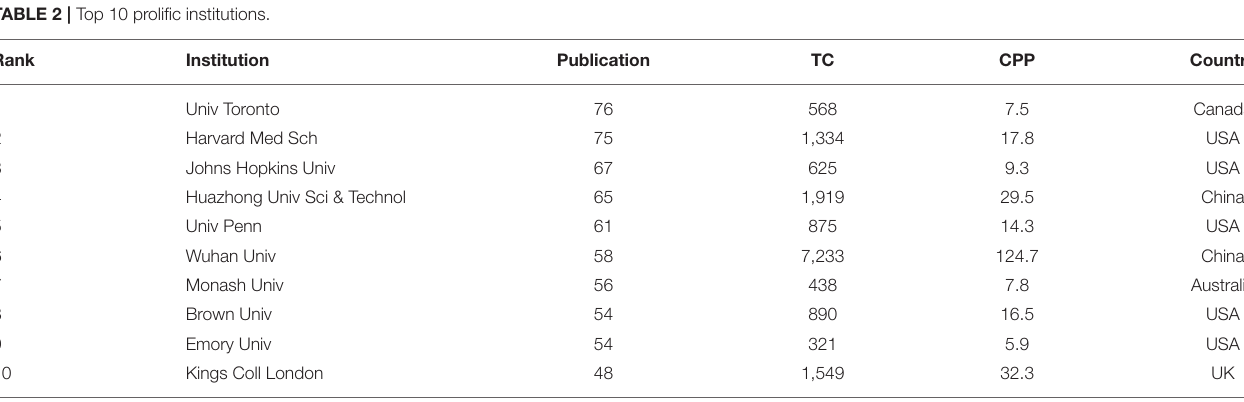
TABLE 2 | Top 10 prolific